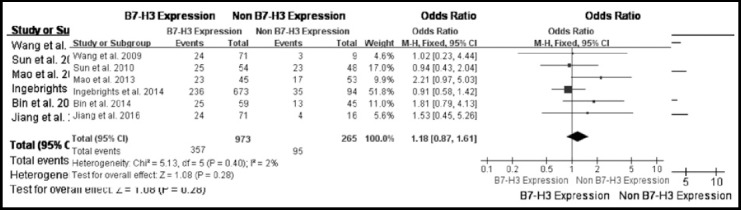
Forrest plot (Fixed-effects model) of odds ratios for the association of B7 H3 expression with lymph node metastasis in patients with CRC.